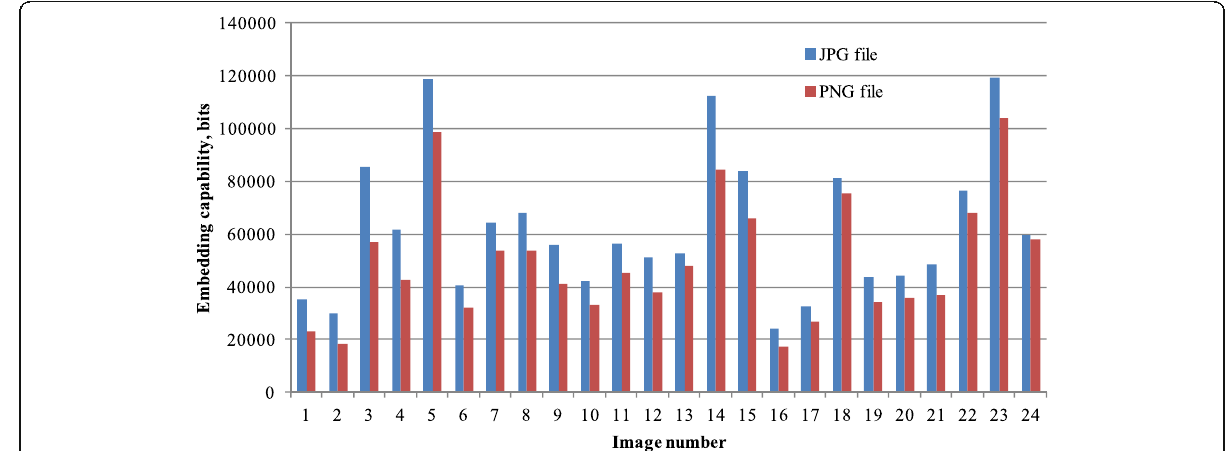
Fig. 5 The embedded average number of bits for each image of extended Kodak image